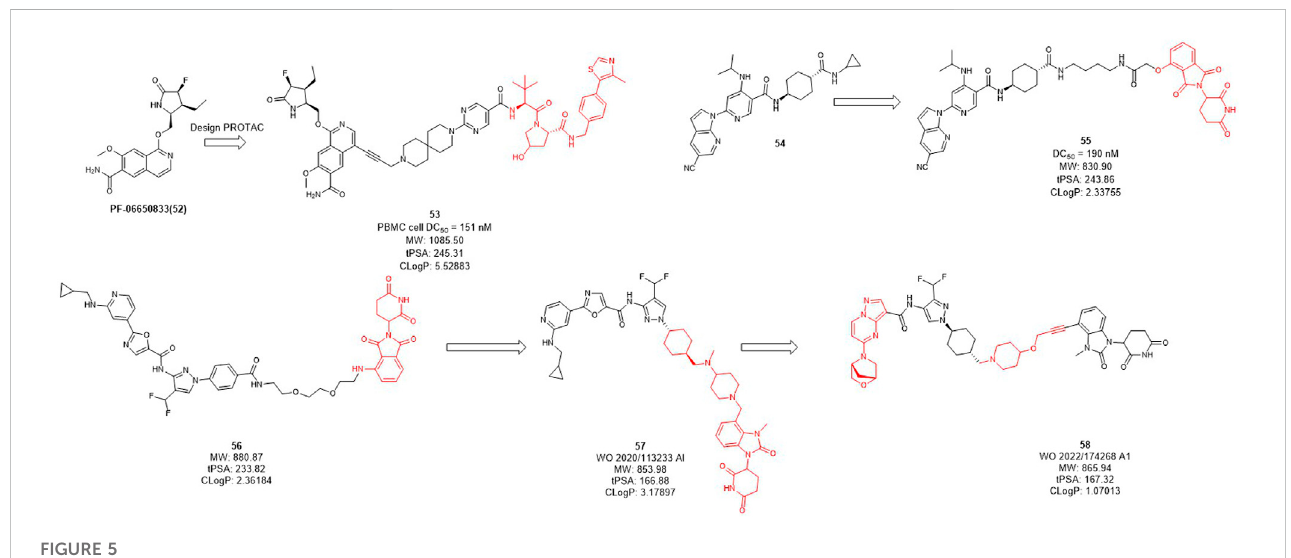
FIGURE 5 Design and optimization of IRAK4